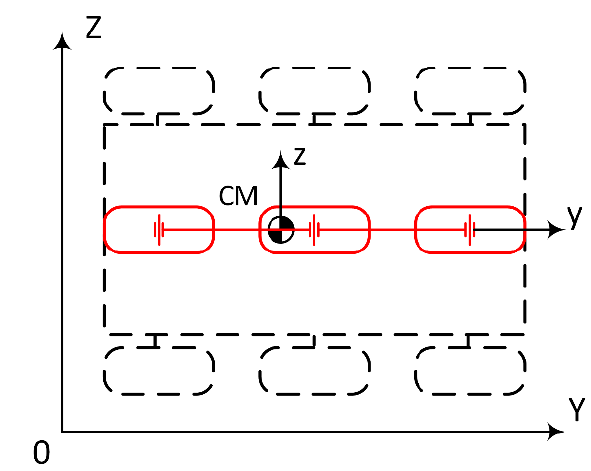
Figure 3. Concept of half-vehicle model [14].